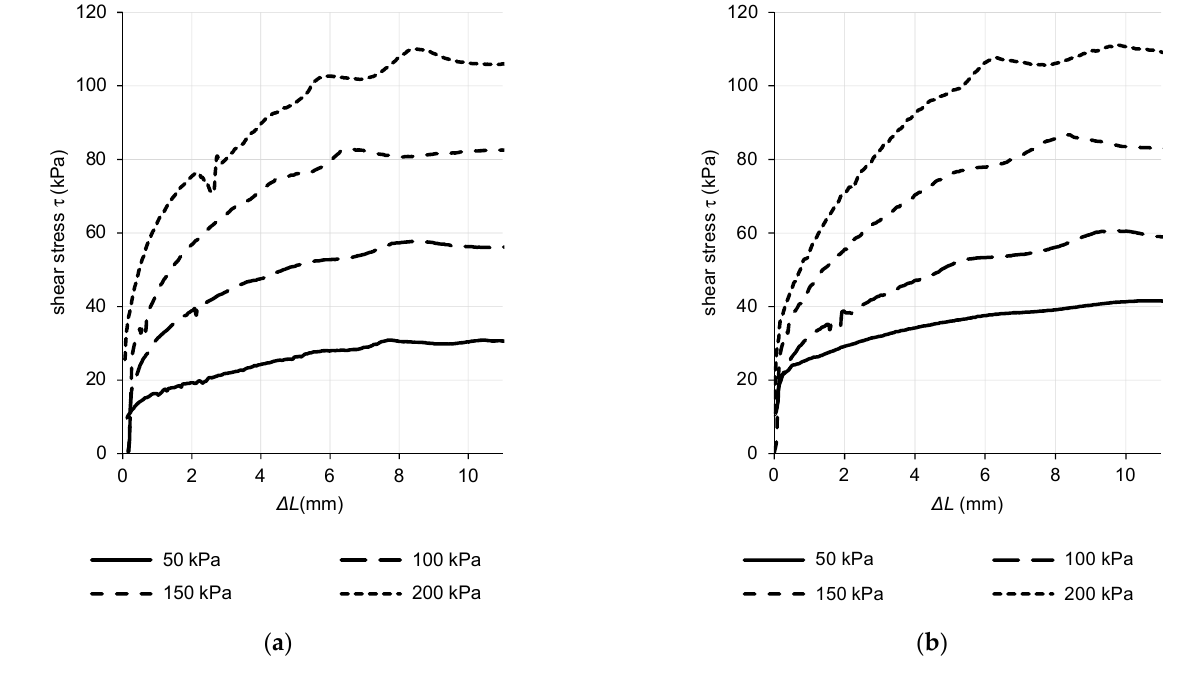
Figure 16. Horizontal displacement–shear stress relation. ( a ) Original sample; ( b ) Boiled sample.